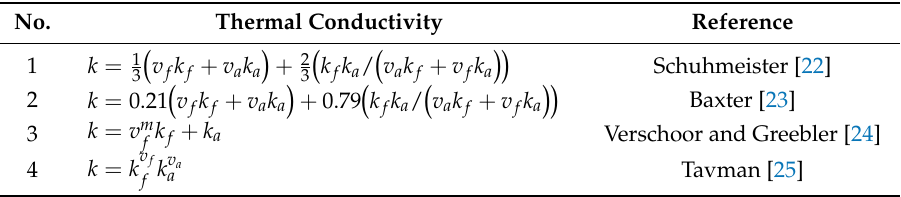
Table 1. Some semi-empirical models for thermal conductivity estimation.